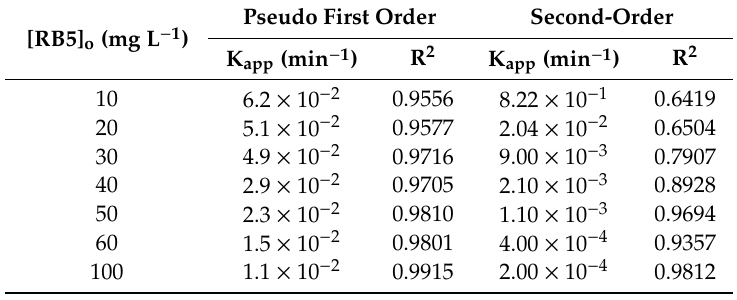
Table 6. The apparent constant of PFO and SO kinetics of RB5 decolorization at di ff erent initial RB5 concentrations.